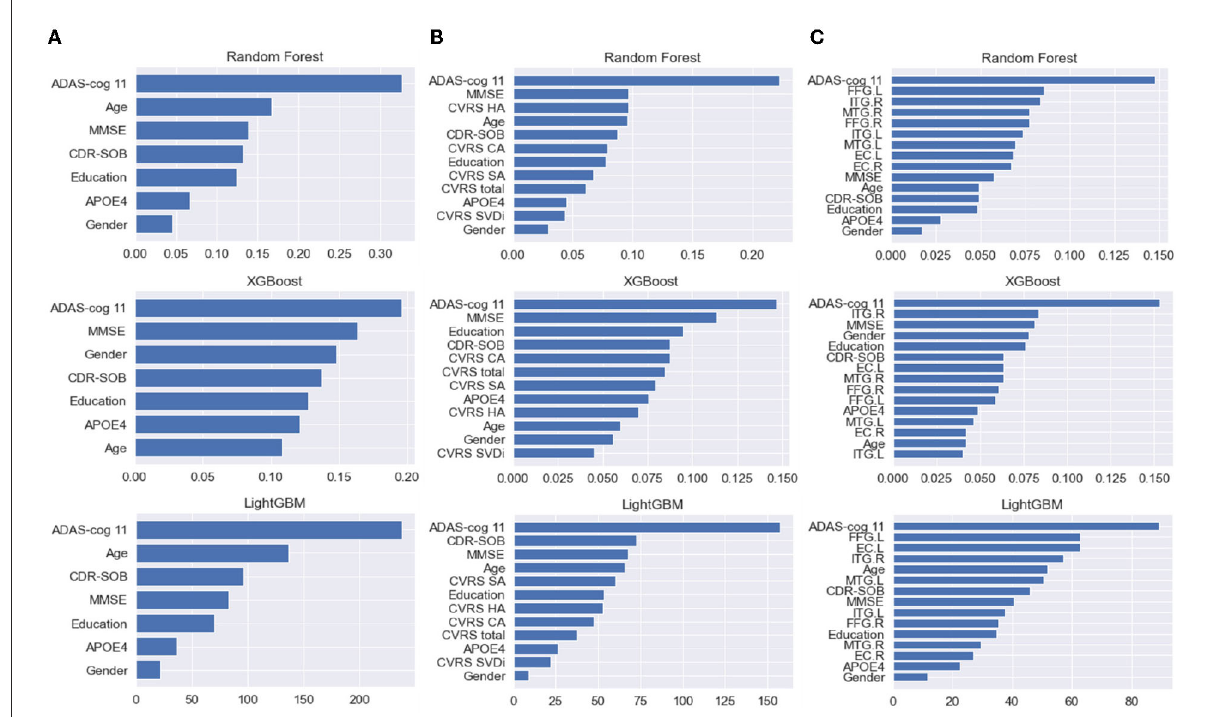
FIGURE4 (A–C) From the left, the feature importance of each ML model with clinical data, clinical data with CVRS, and clinical data with cortical thickness, respectively. CVRS HA, CVRS hippocampal atrophy; CVRS CA, CVRS cortical atrophy; CVRS SA, CVRS subcortical atrophy; CVRS SVD, CVRS small vessel disease; EC.L/R, entorhinal cortex average thickness left/right; ITG.L/R, inferior temporal gyrus average thickness left/right; MTG.L/R, middle temporal gyrus average thickness left/right; FFG.L/R, fusiform gyrus average thickness